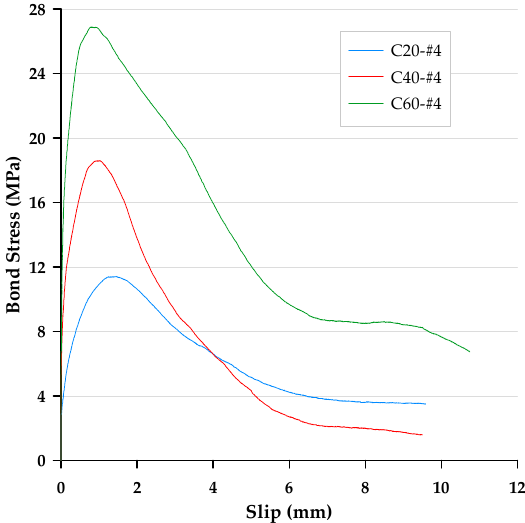
Figure 6. Local bond stress–slip curve for specimens with the #4 rebar.